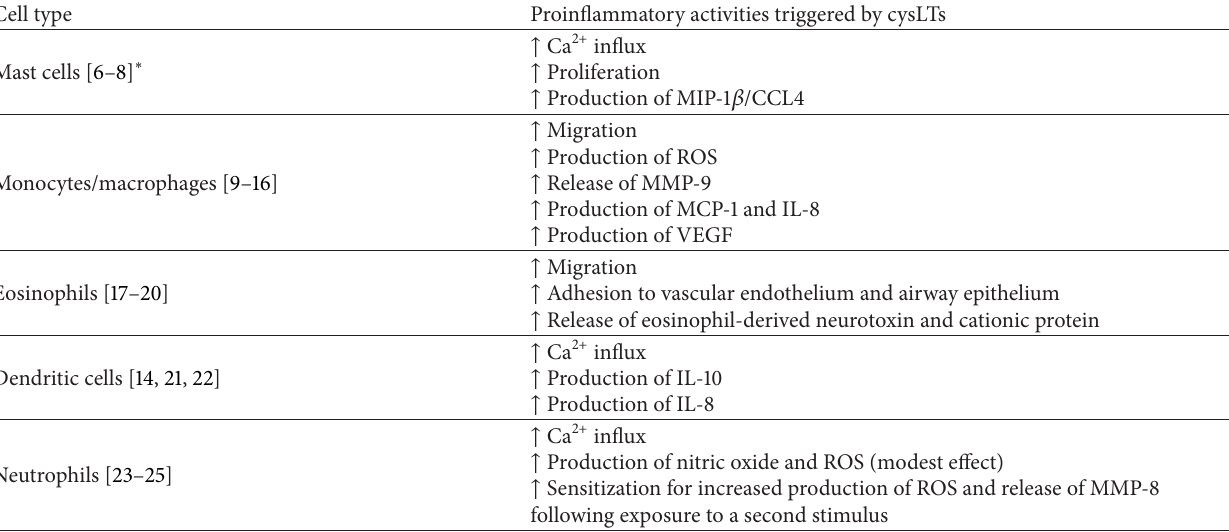
Table 1: Proinflammatory interactions of cysteinyl leukotrienes with cells of the innate immune